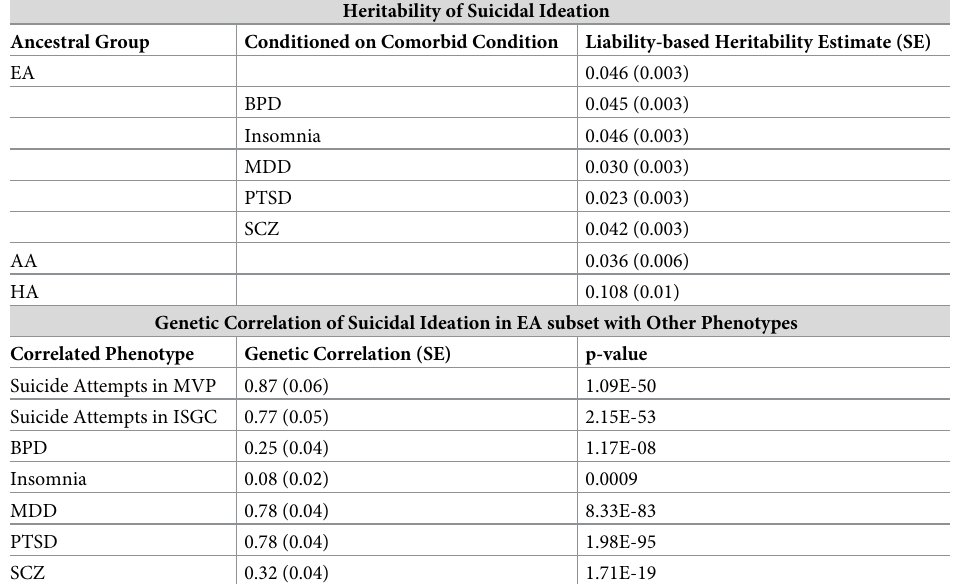
Table 3. Heritability of Suicidal Ideation in the Million Veterans Program and Genetic Correlation with Frequent Comorbid